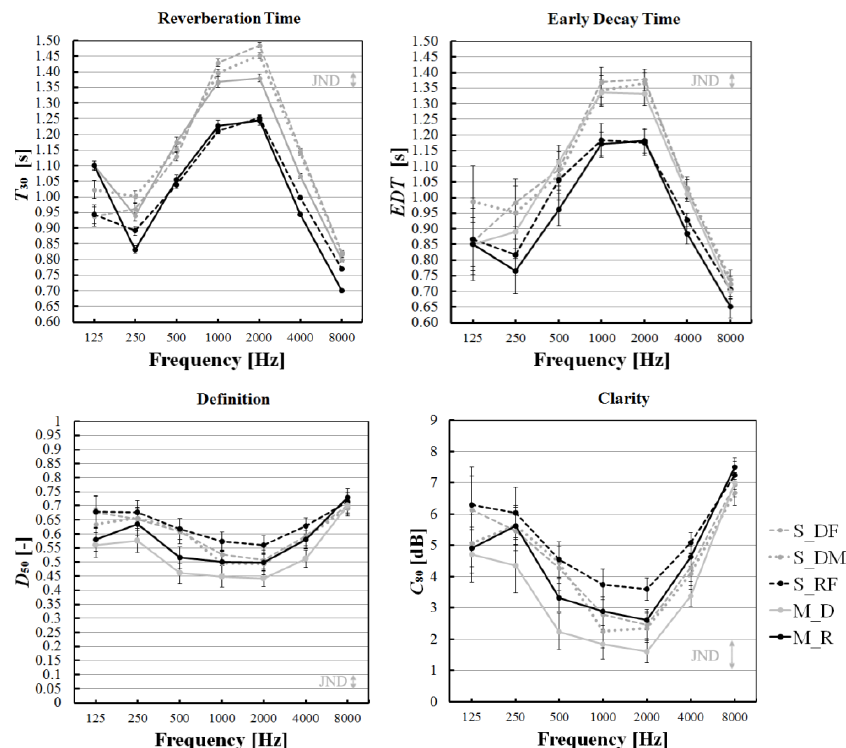
Figure 7. Reverberation time ( T 30 ), early decay time ( EDT ), definition ( D 50 ) and clarity ( C 80 ) simulated and measured values given in octave bands for both reflective (RF) and diffusive (DF and DM) conditions. The step of y -axis is equal to 1 JND of each parameter. S and M indicate the simulation and measurements results, respectively.